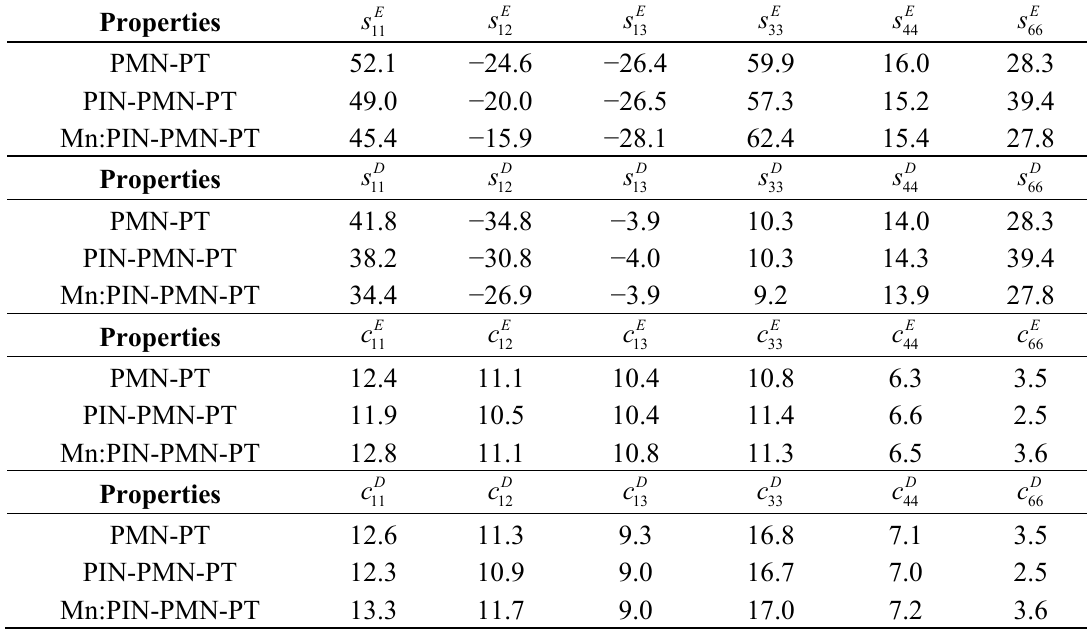
Table 5. Elastic compliance constants, s (10 10 N/m 2